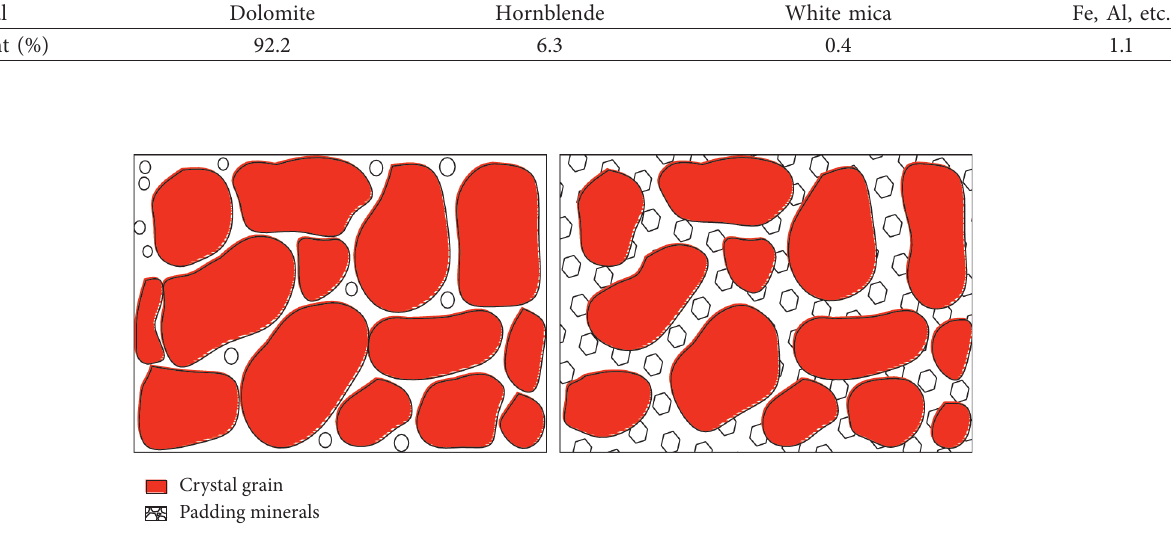
Figure 6: Grain model of the marble sample in this paper. Table 3: Mineral composition of granite used in this